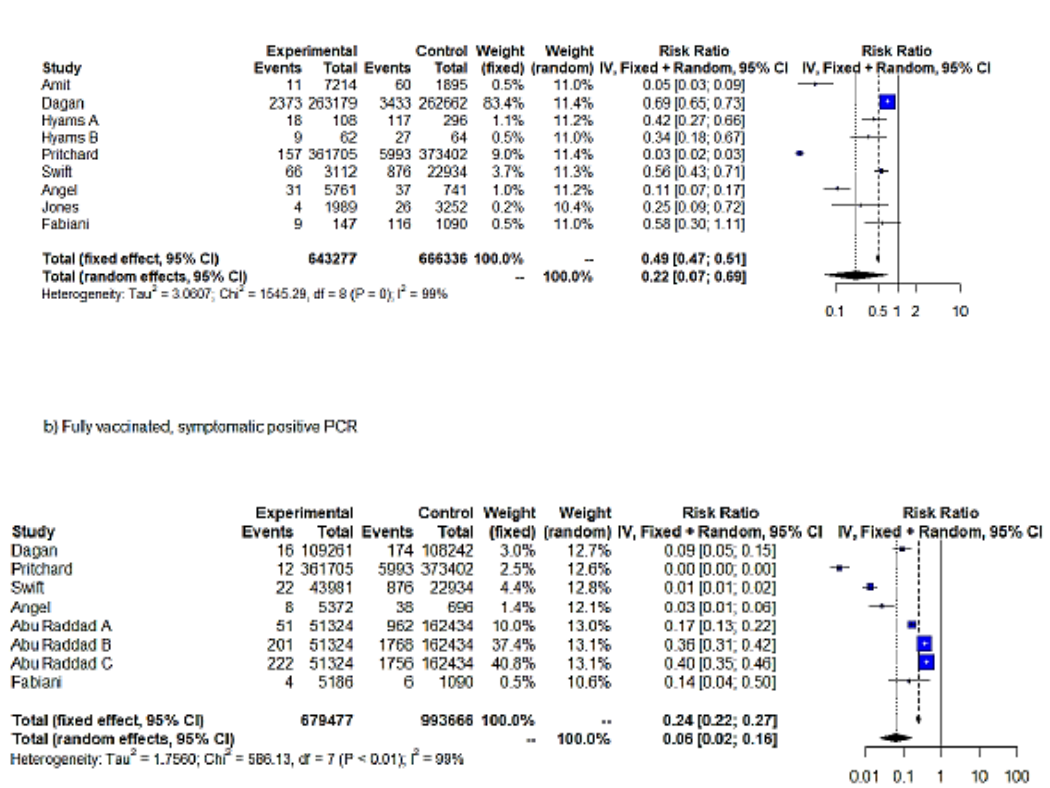
Figure 3. Forest plot, symptomatic positive SARS-CoV-2 PCR RR (95%-CI) ≥ 14 days from first dose uptake ( a ). Forest plot, fully vaccinated. Symptomatic positive PCR RR (95%-CI) ≥ 7 days from full vaccination ( b ). IV method.